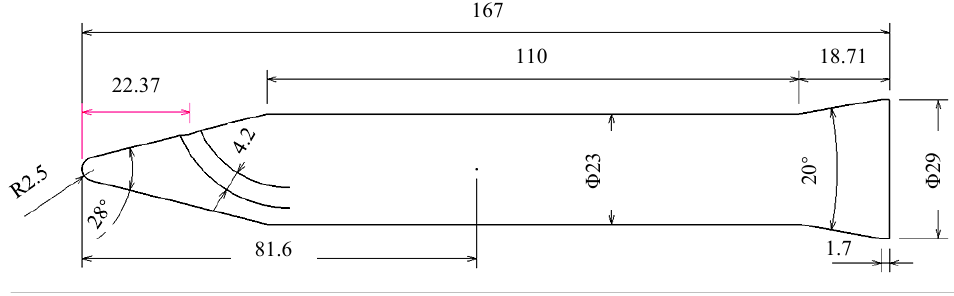
Figure 2. Geometric dimension diagram of revolution body (dimensions are mm).